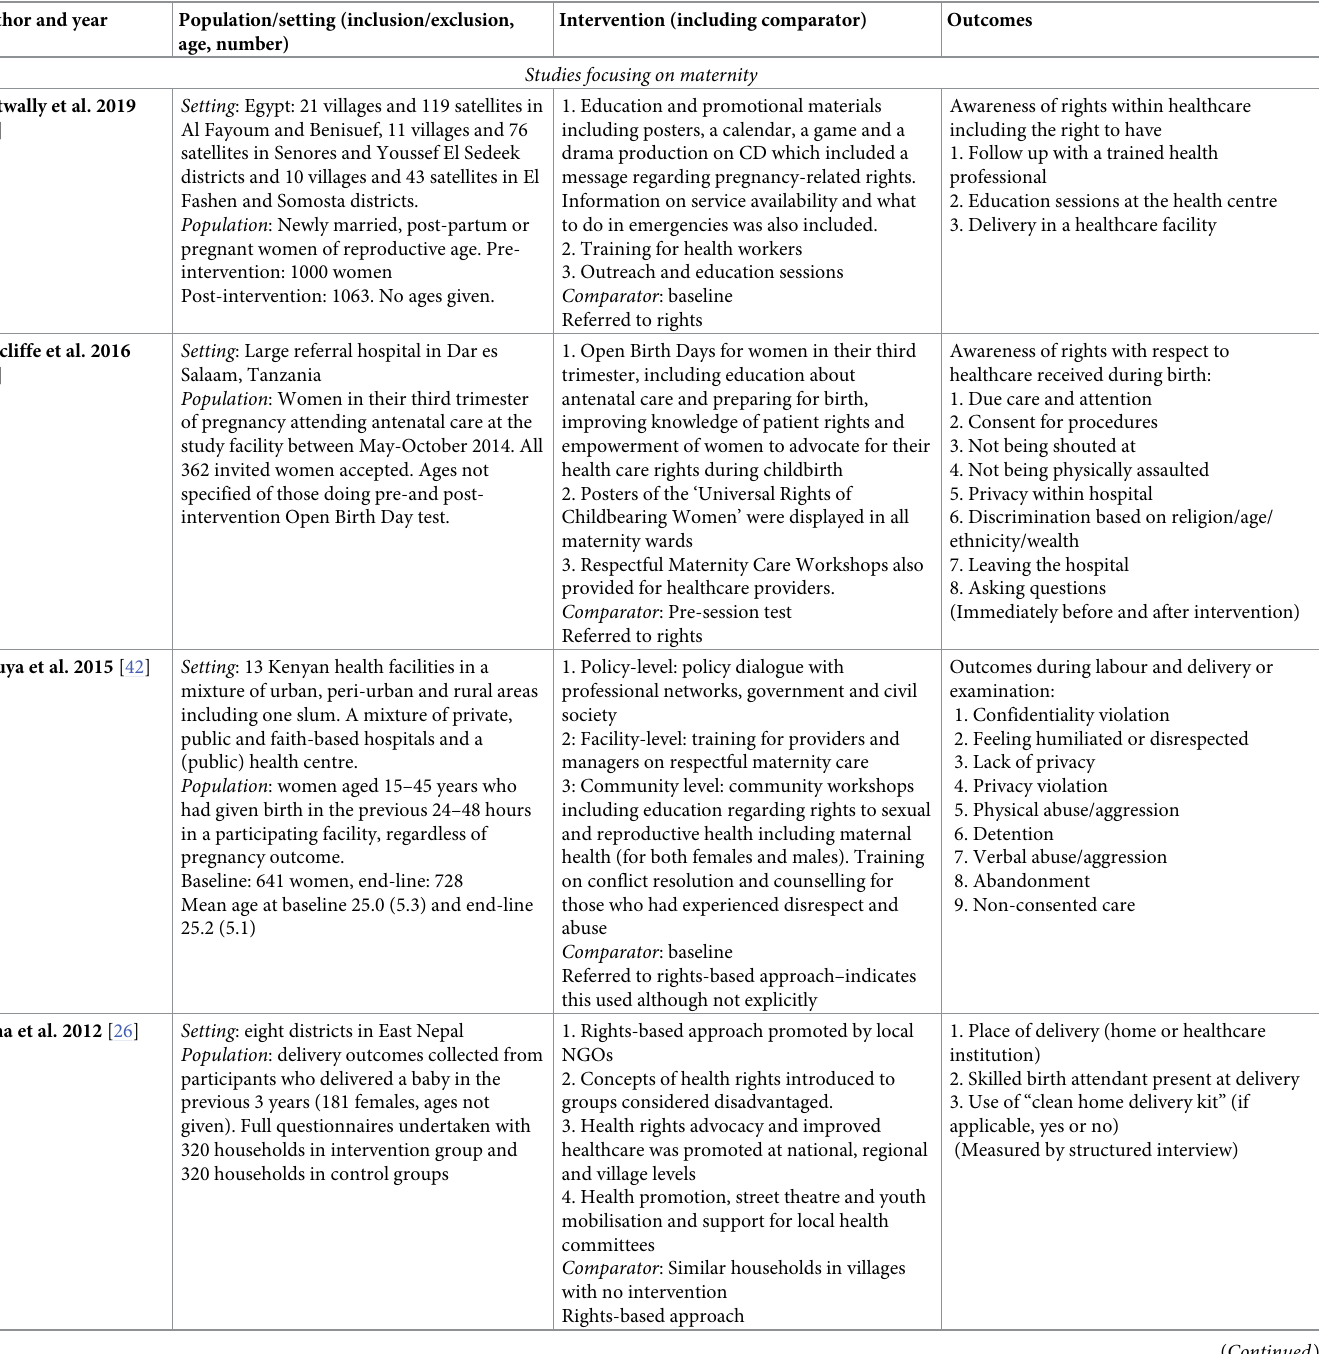
Table 1. Characteristics of included